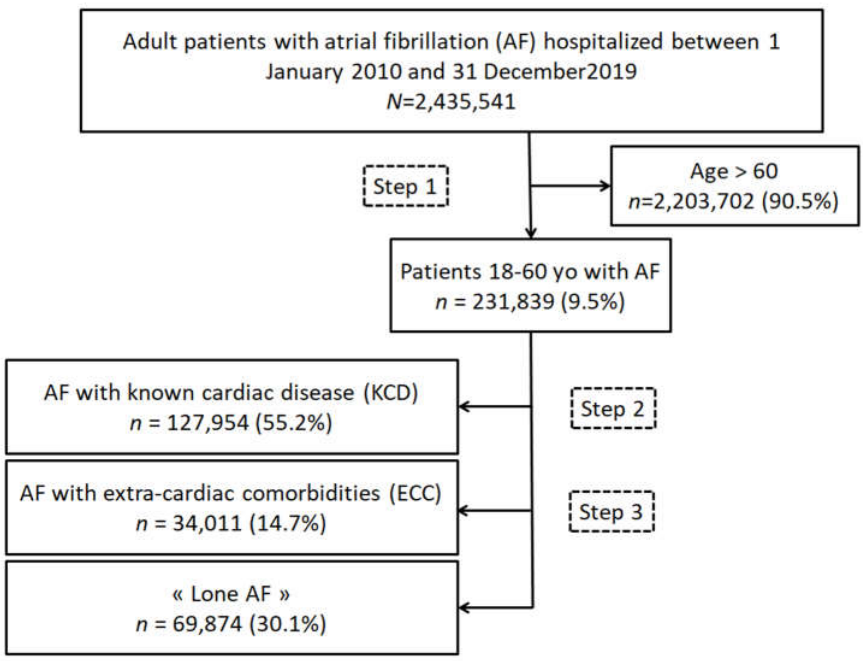
Figure 1. Flow chart of the study population.